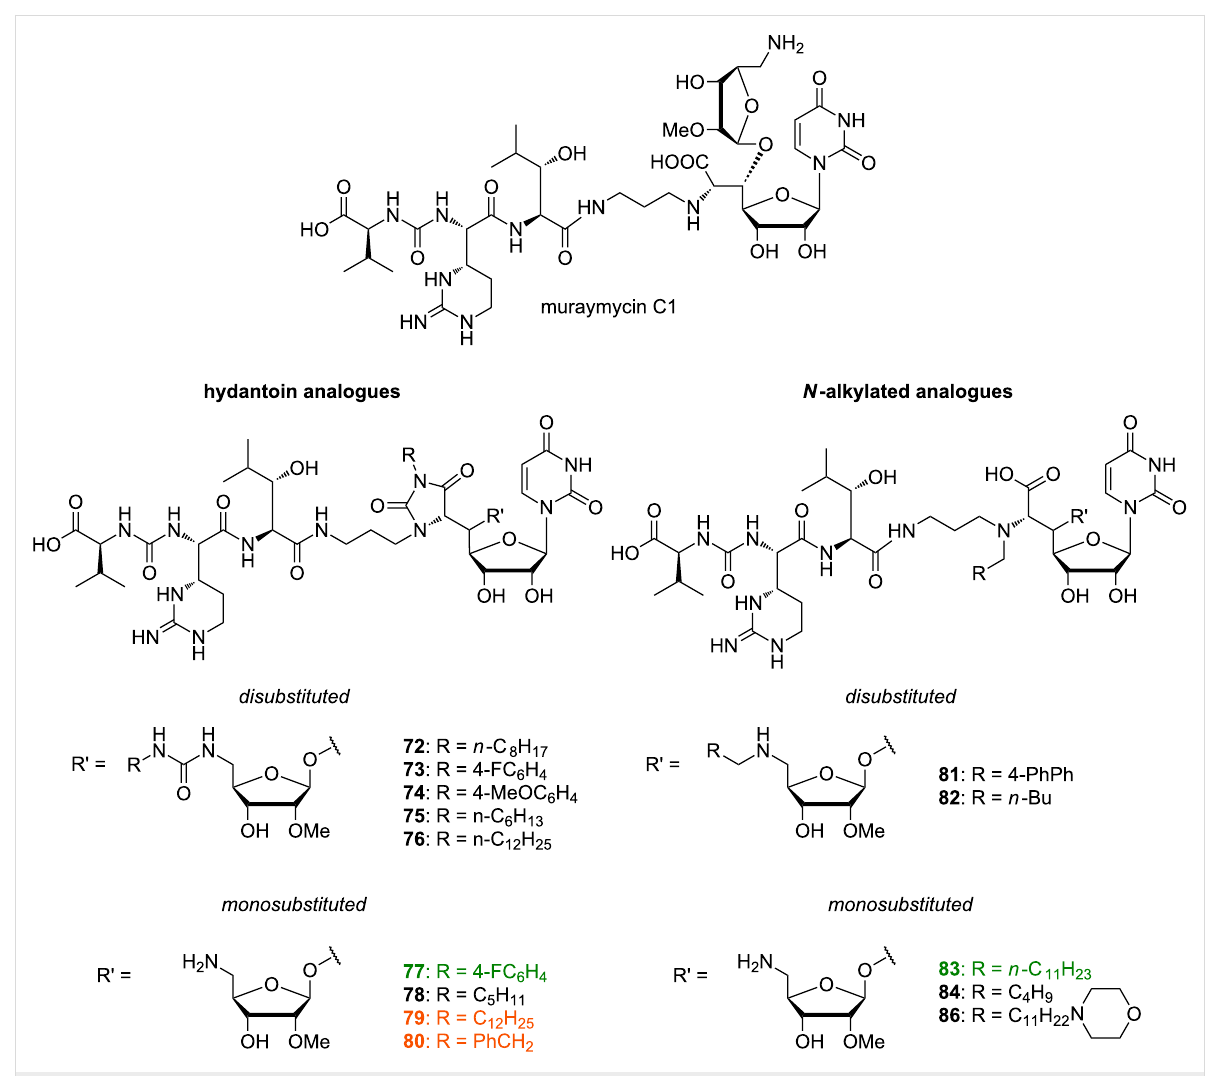
Figure 7: Summary of modifications on semisynthetic muraymycin analogues tested by Lin et al. [86]. Most active compounds are highlighted (in vitro inhibition of lipid II formation at 6.25 μ g/mL: orange; 25–50 μ g/mL: